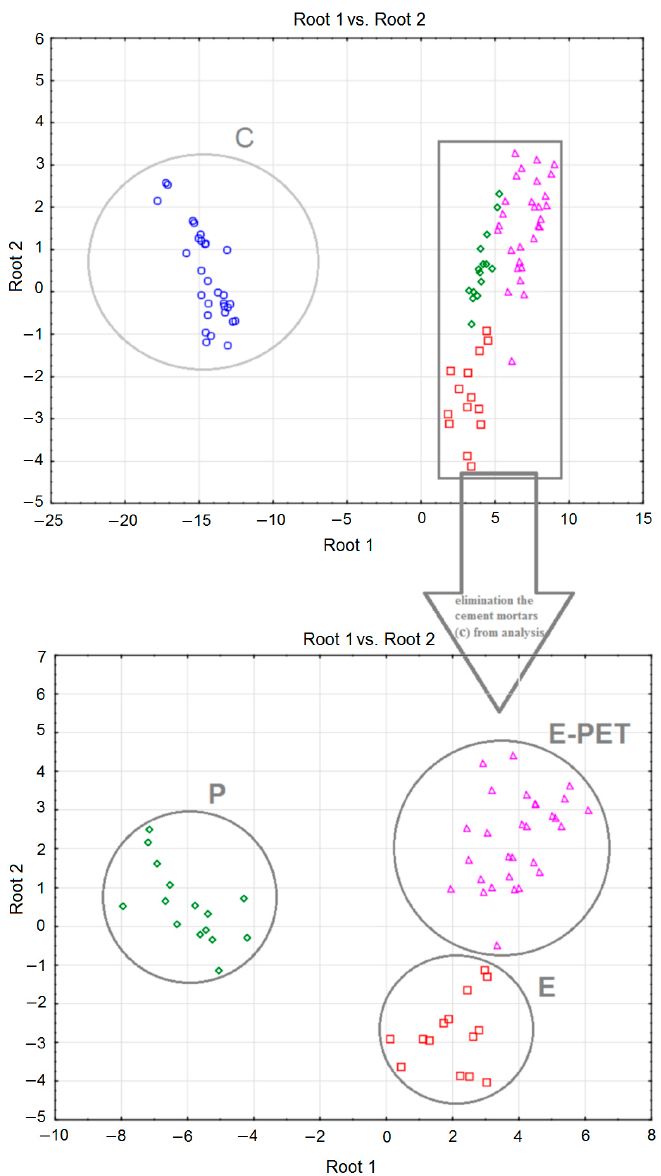
Figure 5. Scatterplots of discriminant functions.